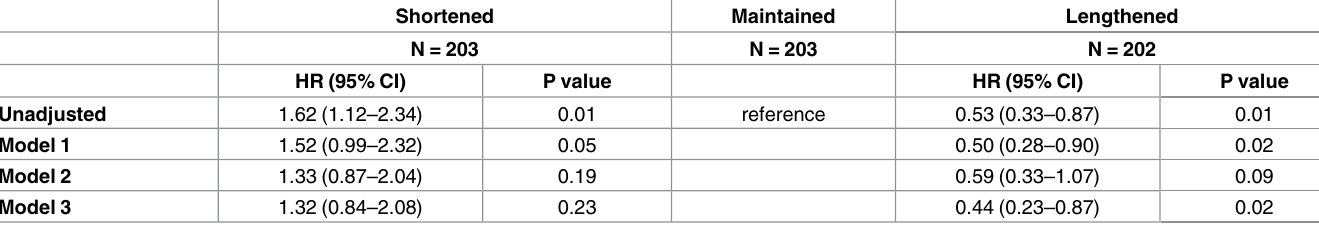
Table 4. Association between category of 5-year telomere trajectory and